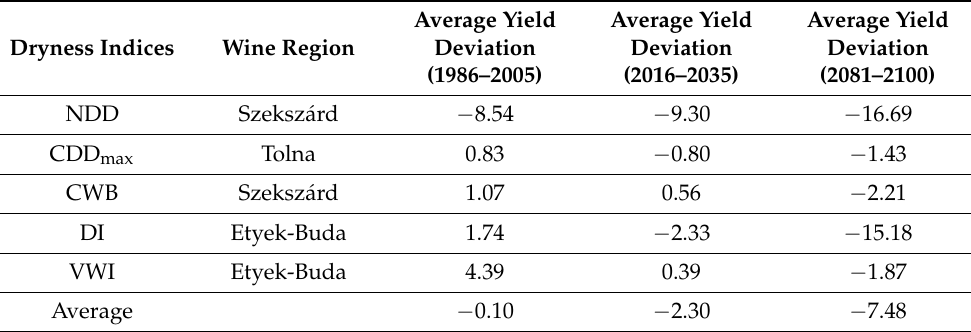
Table 7. Average estimated deviations of wine grape yield (q/ha) from the agricultural trends produced based on the regression coefficients of the best quadratic fits of dryness indices in the different 20-year periods. The deviations for which the t-test indicated significant differences are set in italics (two such pairs are found, both for the distant future).